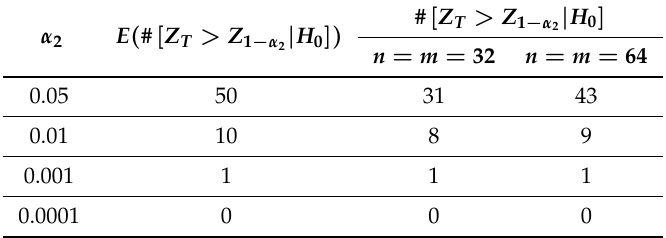
Table 7. Expected E ( # [ Z T > Z 1 − α samples of 1000 values of Z t for n = m , in H i random matrices.